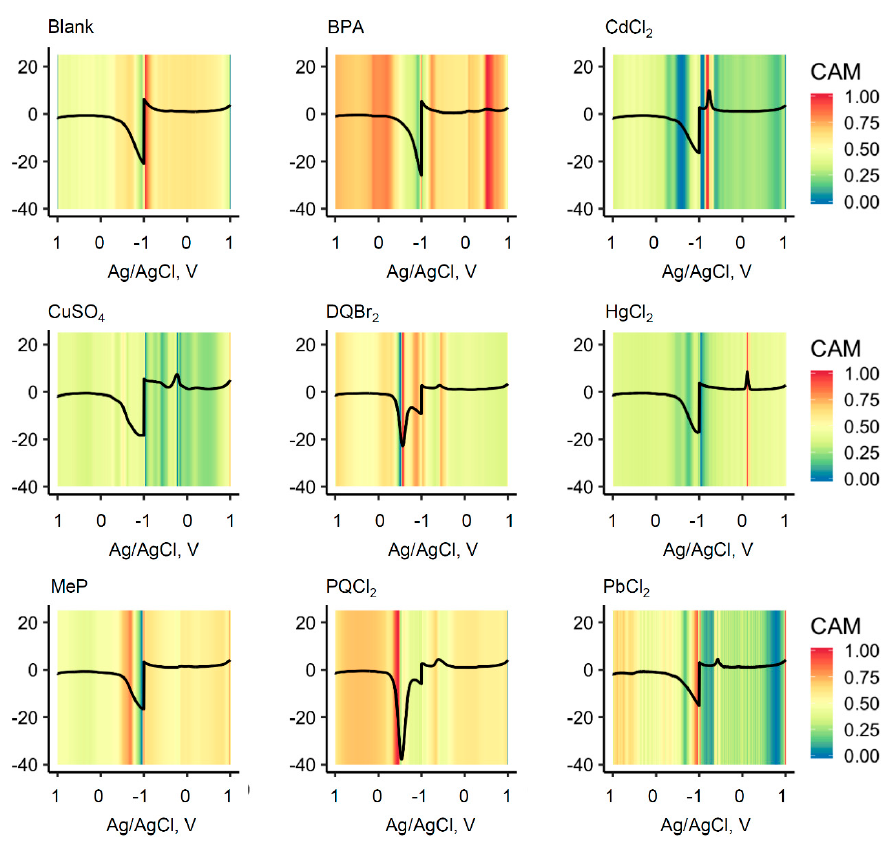
Figure 7. Class activation maps. Representative class activation maps (CAMs) of the compounds in the study.